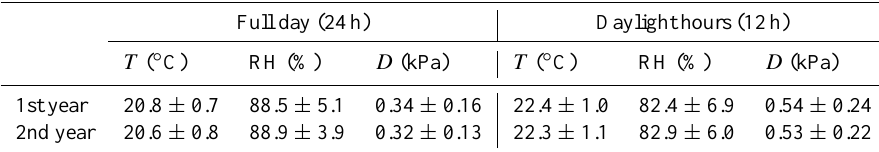
Table 1. Means of air temperature ( T ) , relative humidity (RH) and vapor pressure deficit ( D) at mid-canopy height (16m) in the two experimental years for full days and the daytime periods only in the Pono